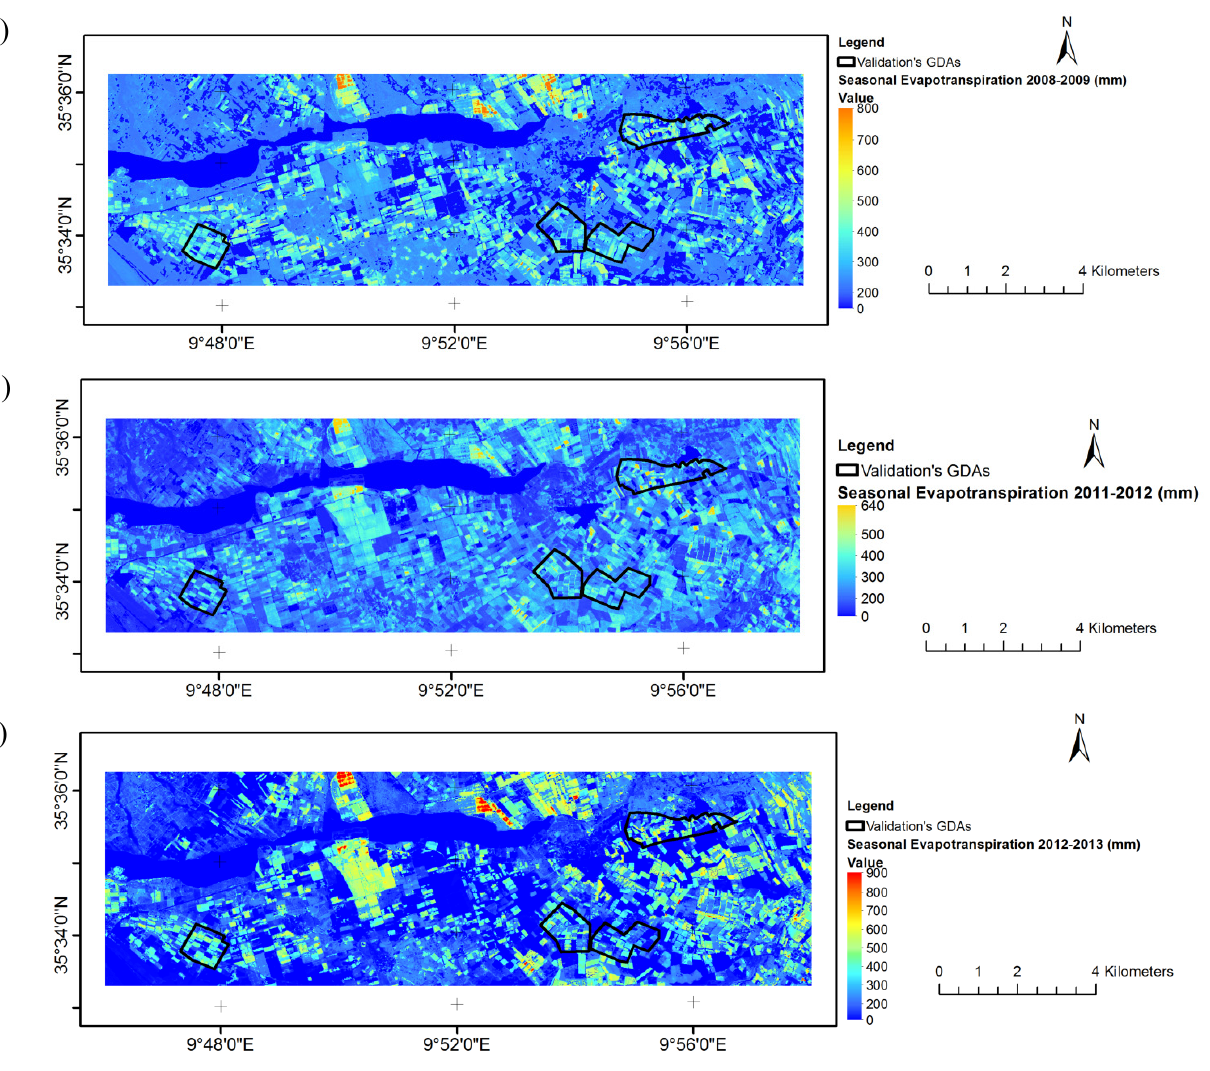
Figure 7. Modeled ET over the study area for the ( a ) 2008–2009, ( b ) 2011–2012 and ( c